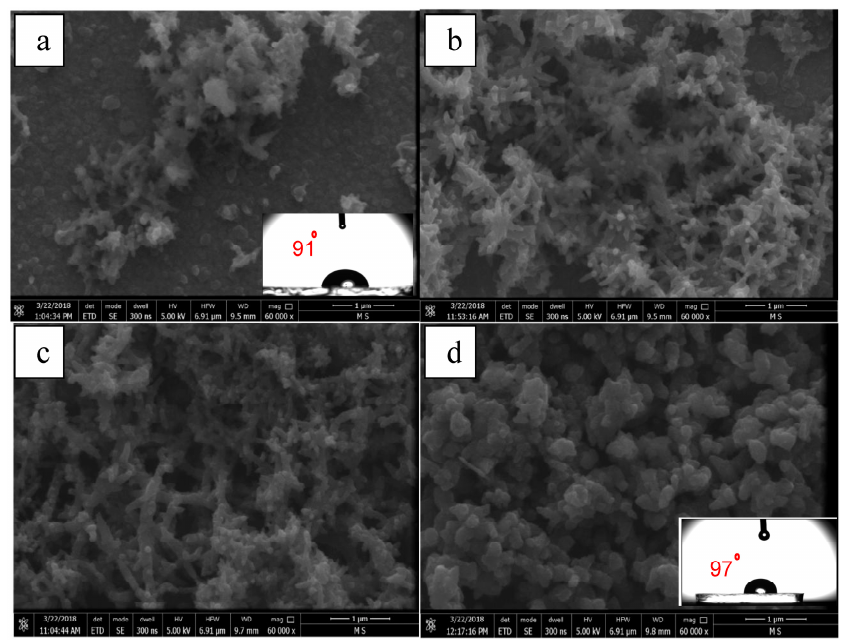
Figure 8. FE-SEM images of PANI films deposited on ITO in the presence of 0.5 M H 2 SO 4 and 0.1 M aniline with a constant potential range (–0.5 to +1.5 V) and at different cycles numbers: ( a ) 5, ( b ) 10, ( c ) 20, and ( d ) 30 cycles. FE-SEM images show the water drop contact angles (CAs) imbedded on the respective surfaces.